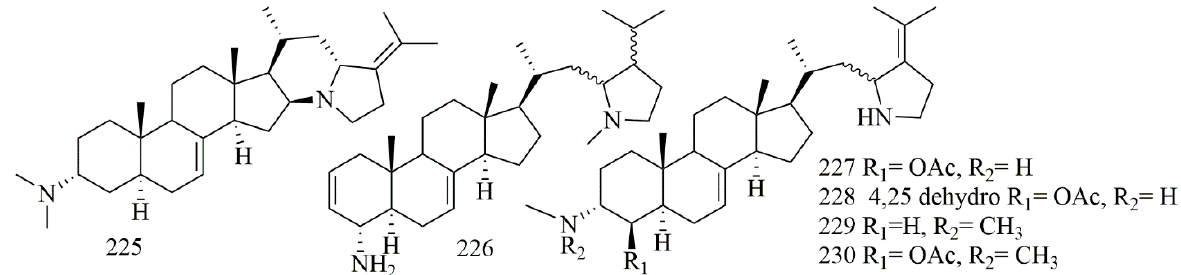
Figure 17. Steroid alkaloid structures isolated from marine sponges. Table 17. Cytotoxic activity of Steroidal alkaloids.